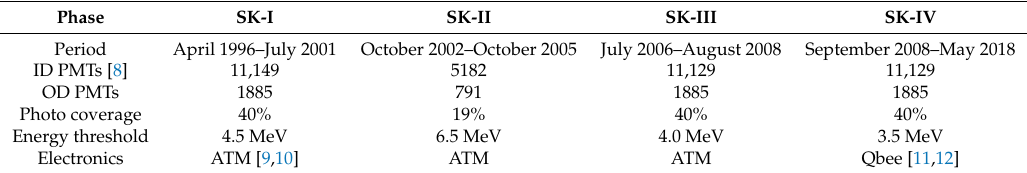
Table 1. Experimental phases of Super-Kamiokande detector. For the energy threshold, the recoil electron kinetic energy is